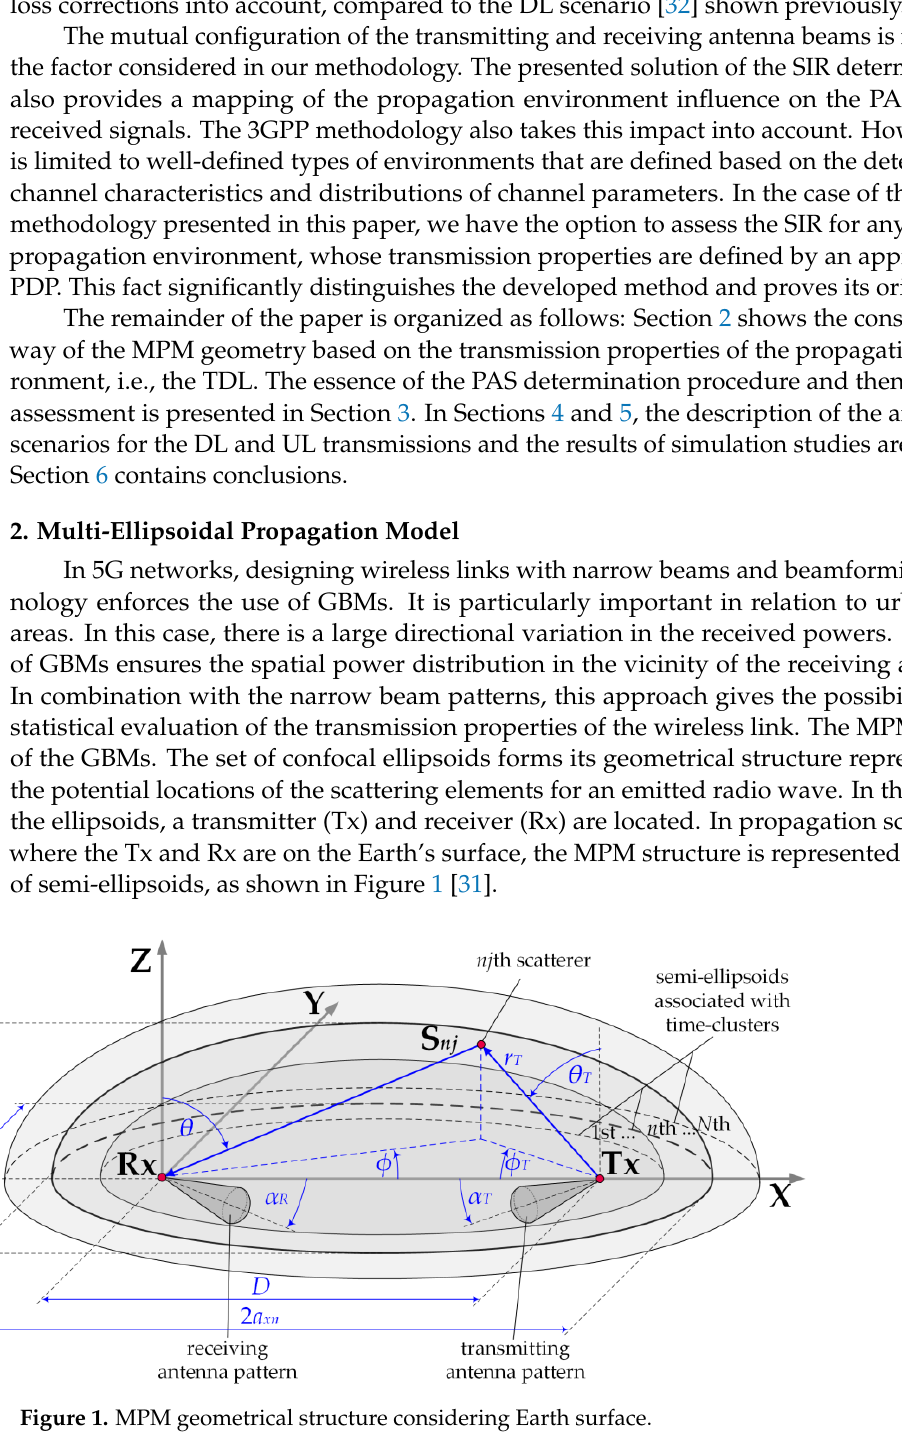
Figure 1. MPM geometrical structure considering Earth surface.